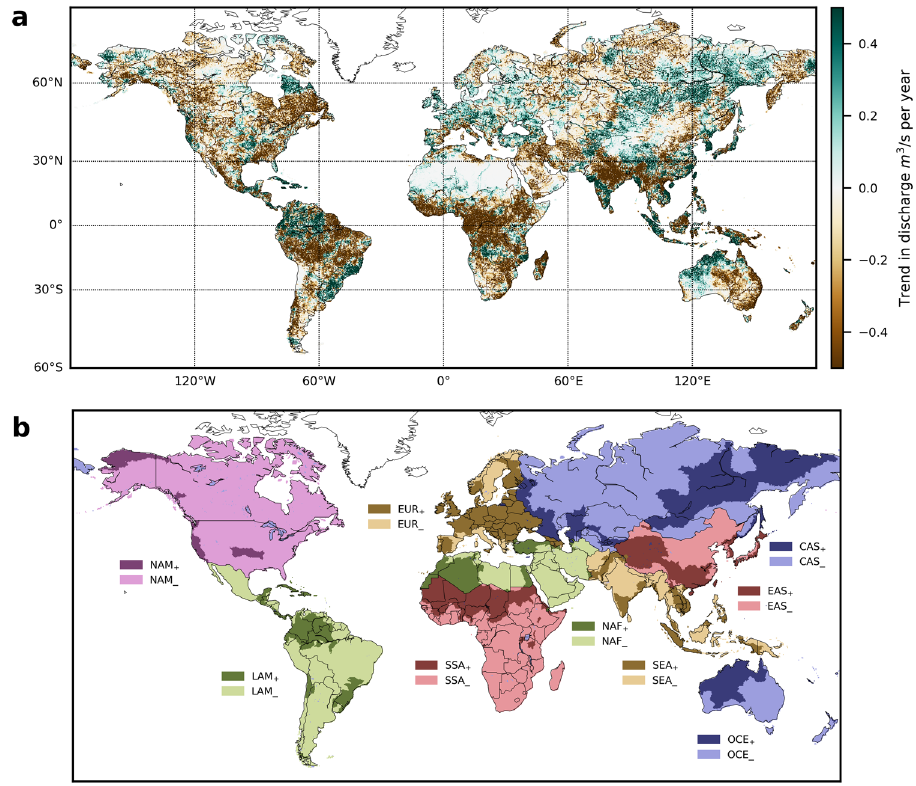
Fig. 1 Discharge trends and de fi nition of regions. a Absolute trends in annual maximum daily discharge in the time period 1971 – 2010 (signi fi cance levels are shown in Supplementary Fig. 3). b Map of the nine geographical world regions: North America (NAM), Eastern Asia (EAS), Europe (EUR), Latin America (LAM), Central Asia & Russia (CAS), South & Sub-Saharan Africa (SSA), South & South-East Asia (SEA), North Africa & Middle East (NAF), Oceania (OCE) chosen according to geographical proximity and similarity of socio-economic structure. These regions are then further divided into subregions assembled of river basins with positive ( R + , dark colors) and negative discharge trends ( R – , light colors) (Supplementary Fig.